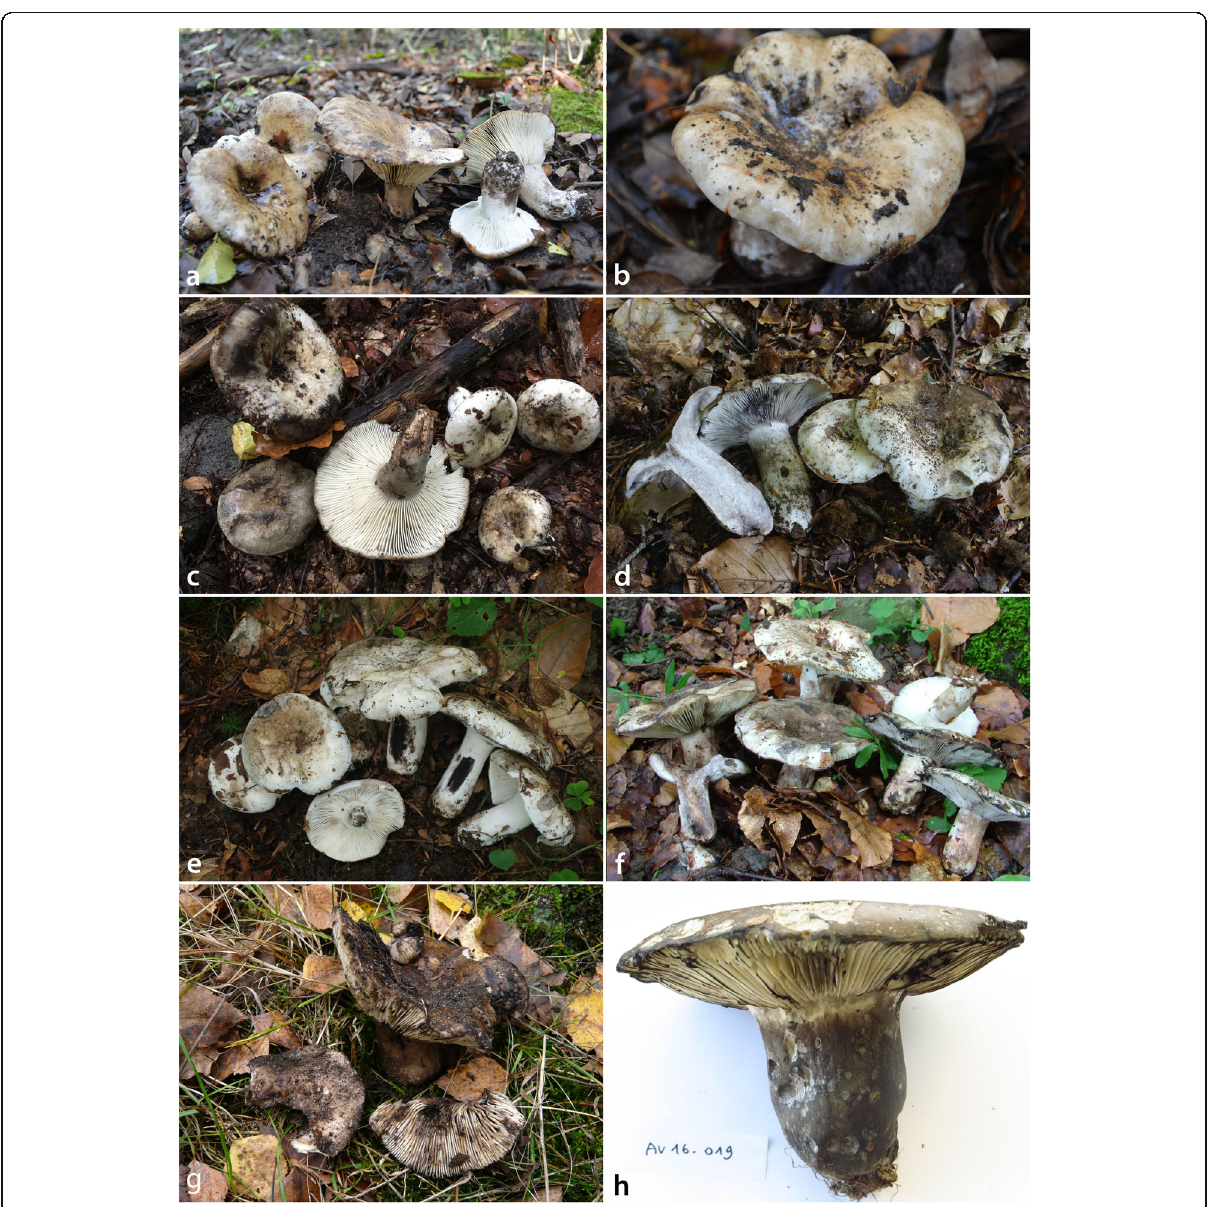
Fig. 3 Basidiomata. a-b Russula nigrifacta (RDL 16 – 044, holotype). c-f Russula albonigra (c: SAV F-20197, epitype; d PRM 934322; e PRM 924409; f SAV F-20177). g Russula ambusta (FH 2008 ST01). h Russula ustulata (AV 16 – 019,